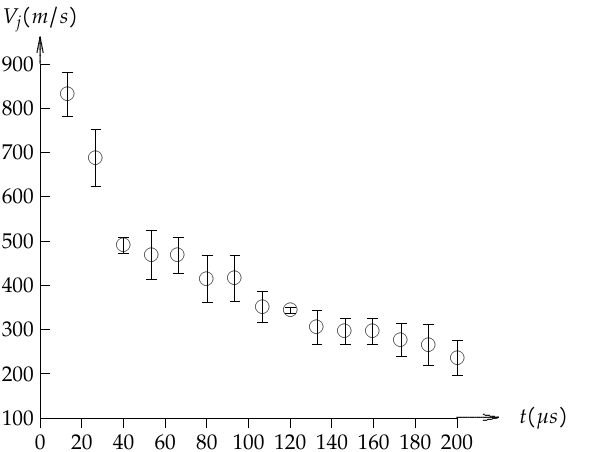
Figure 39. Average drag reduction vs dimensionless energy.